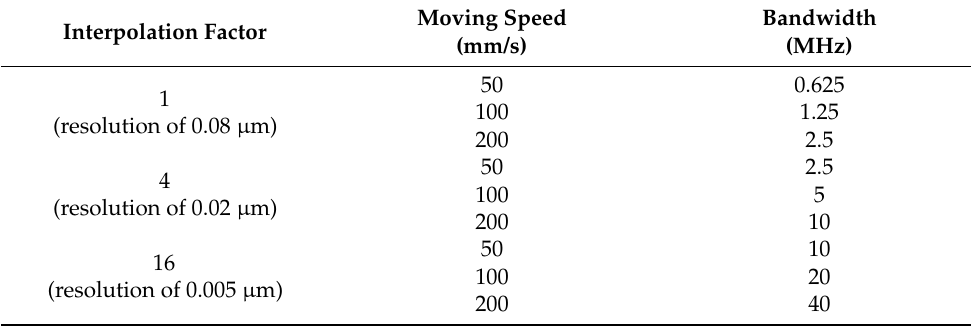
Figure 2. Schematic diagram of interpolation signal converting. Table 1. Relationship between the interpolation factor, moving speed, and the signal bandwidth. Interpolation